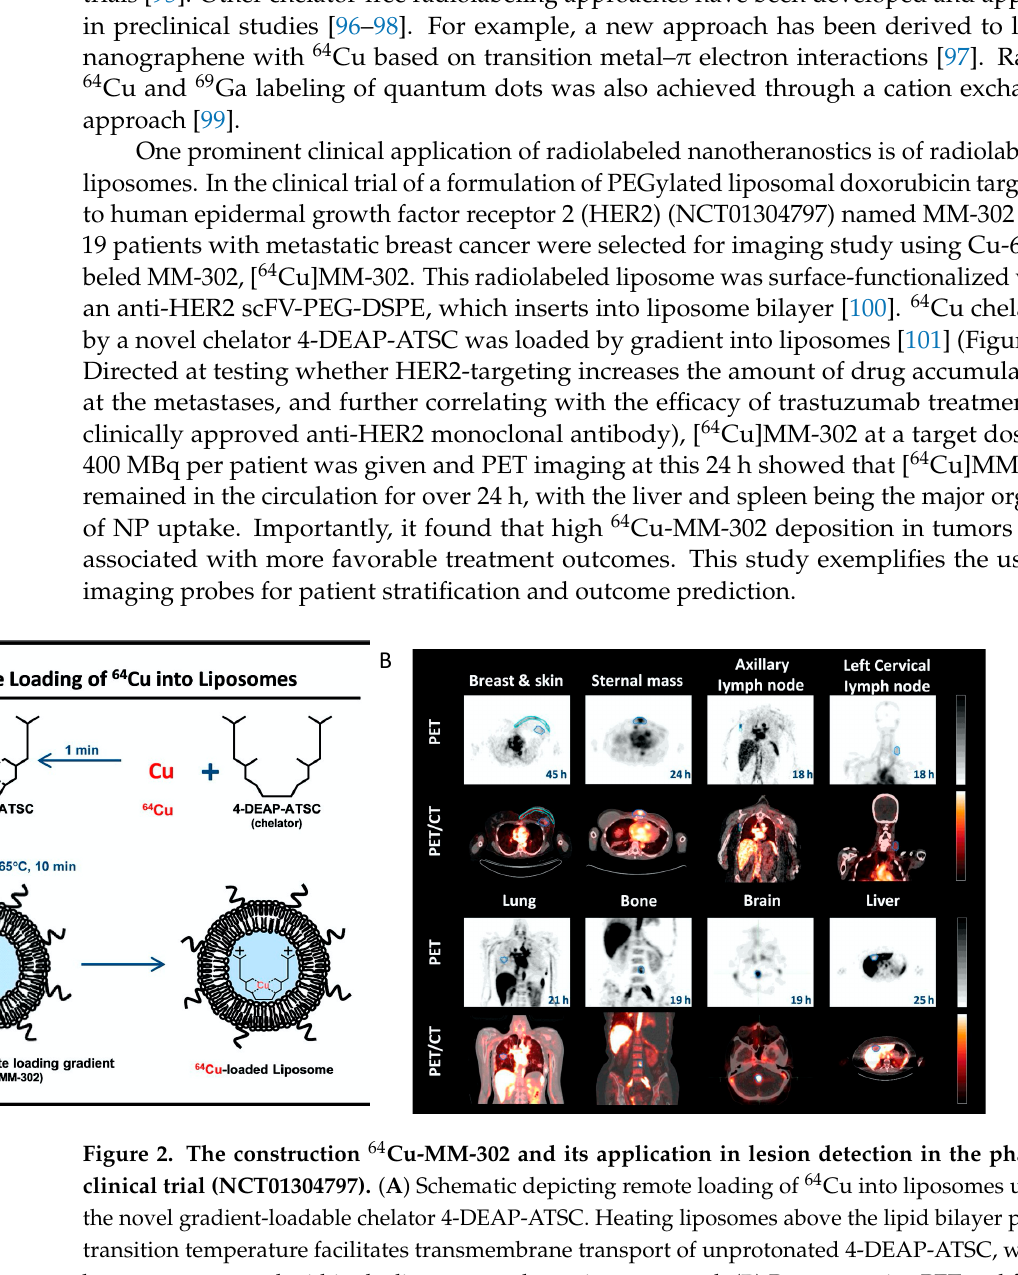
livered to tumor versus normal tissues before α particle therapy due to similar